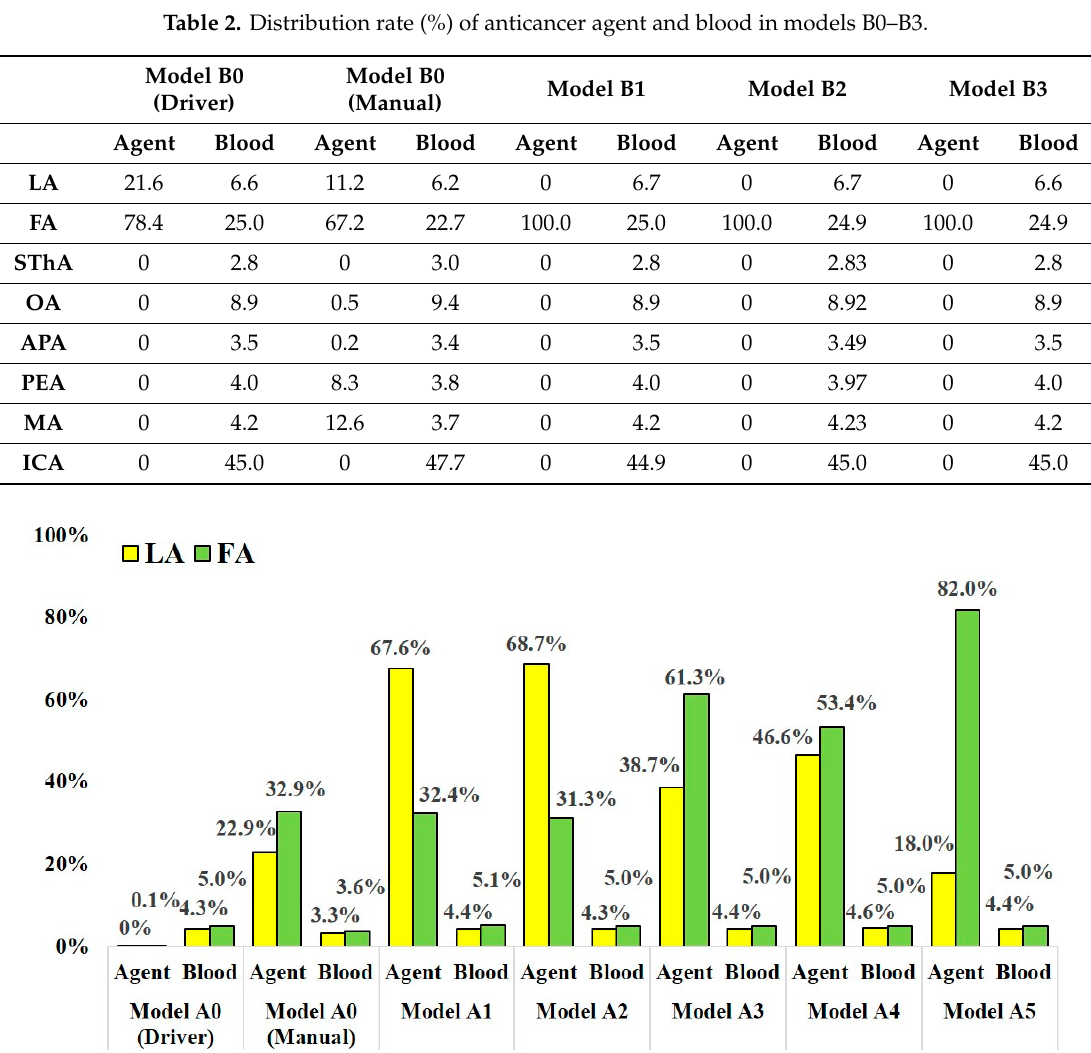
Figure 6. The distribution rate of anticancer agent and blood at the LA and FA in models A0–A5.